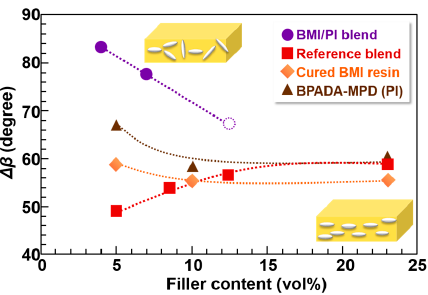
Figure 9 . Full-width at half-maximum of the azimuthal intensity distribution of (100) diffraction, Δ β , for four kinds of composite films with various n-ZnO contents.